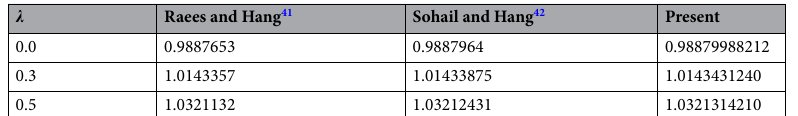
1 / 2 Table 6. Comparison of the ( 1 / 2Re x C f x ) for present work with published work. When Pr = 10.2, Nt = Nb = 0.2, RH = Le = 0.5, Ks = 0.045 .